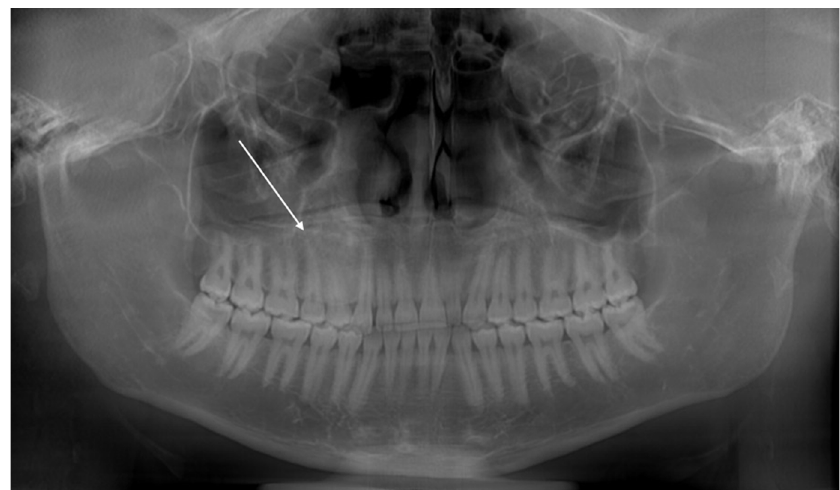
Fig. 2. Panoramic X-ray showing a slightly osteodense lesion in relation to teeth 13 – 16. Root divergence is noted on 13 and 14.